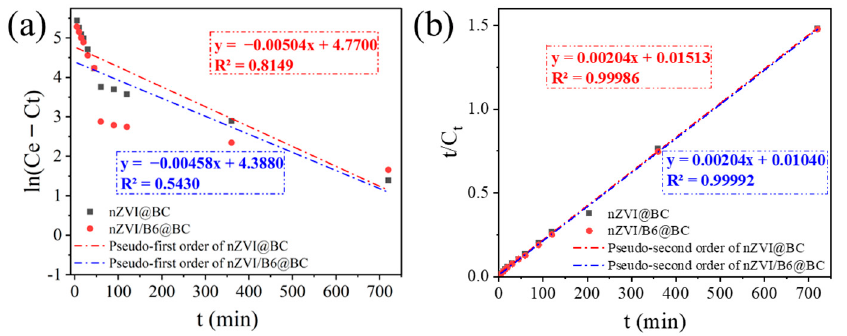
Figure 8. Degradation kinetic modelling ( a ) pseudo-first order, and ( b ) pseudo-second order of OTC on nZVI@BC and nZVI/B6@BC (initial concentration = 500 mg/L, adsorbent concentration = 1.0 g/L, temperature = 25 °C, pH = 3.5).